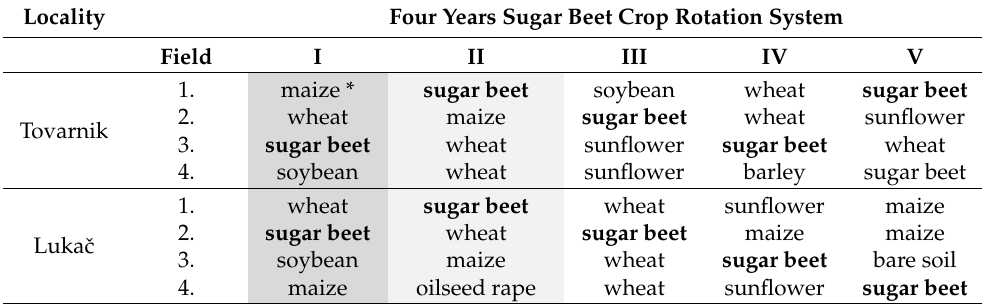
Table 1. Historical crop rotation at the locations included in the